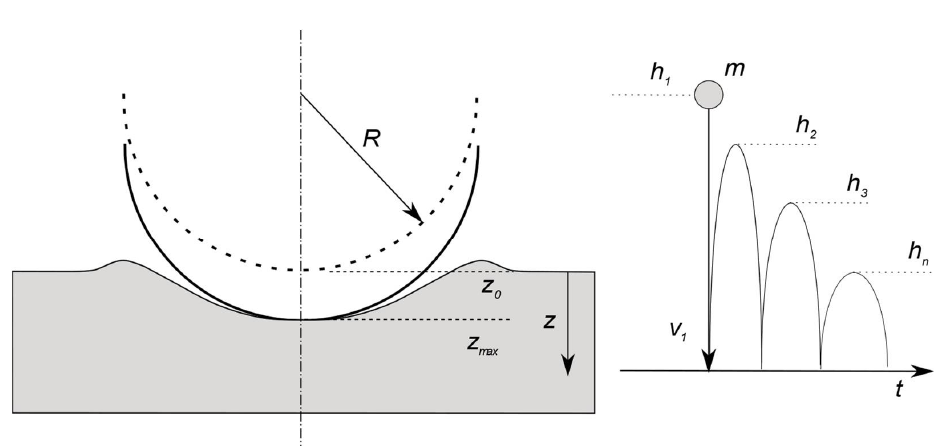
Figure 11. The contact interpretation between the half-space and a ball of radius R (left). An illustration of the bouncing ball after the impact.